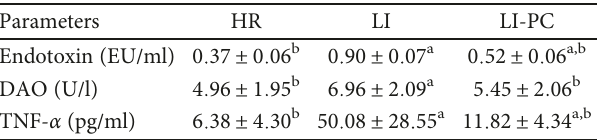
Figure 3: Transmission electron microscopy of ileal histopathology (magni fi cation, × 15,000): (a) normal control group; (b) liver injury and treated with phosphatidylcholine group; (c) liver injury group. Table 2: Comparison of the plasma endotoxin level and serum DAO activities and TNF- α levels among the experimental